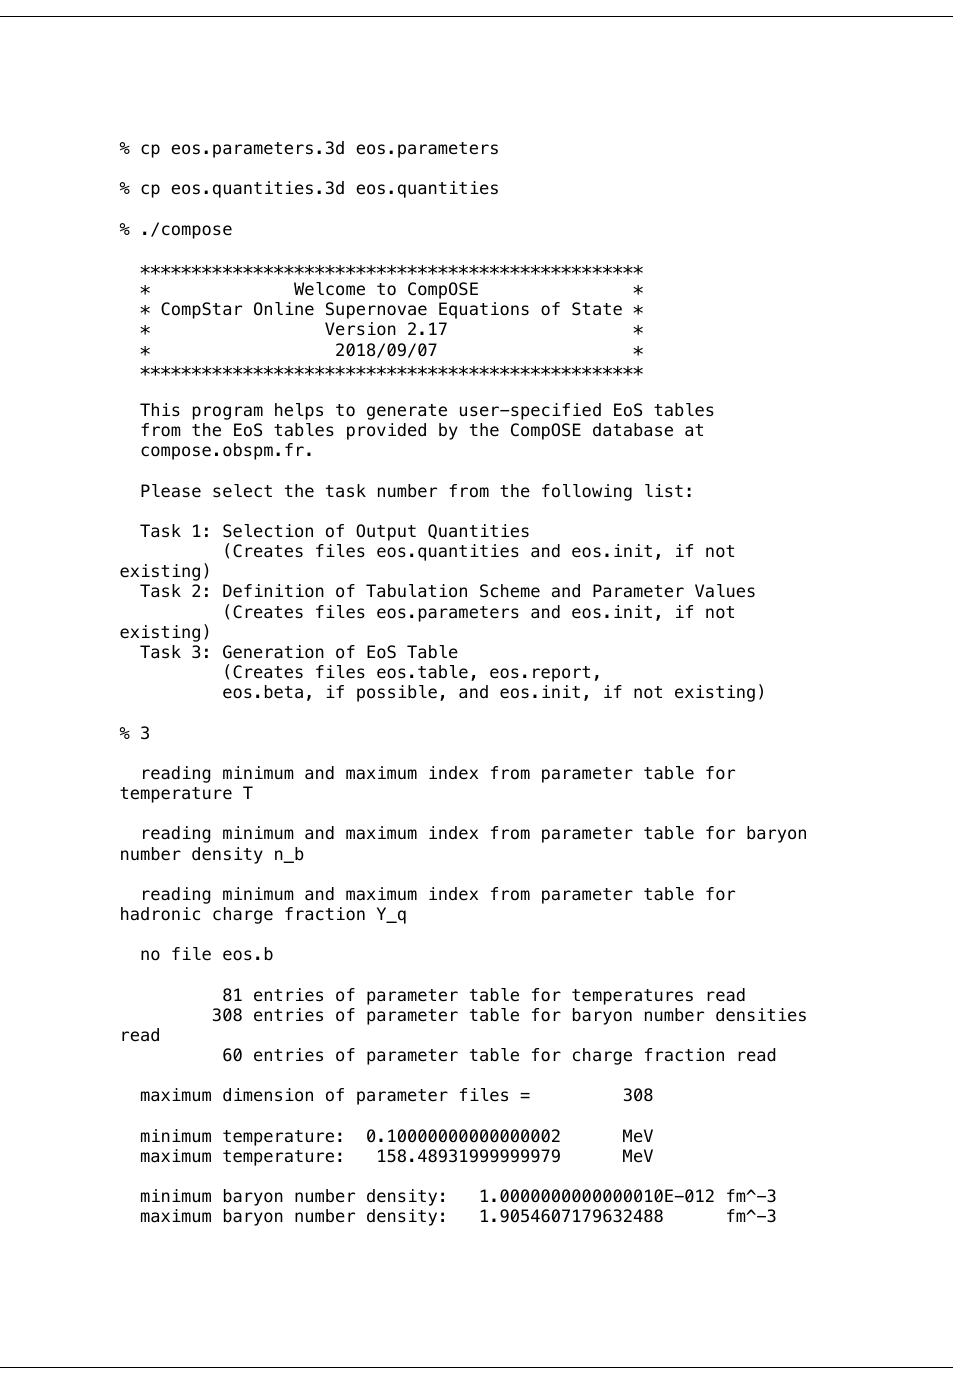
Figure A3. Snapshot when running compose for extracting compositional information from a general purpose